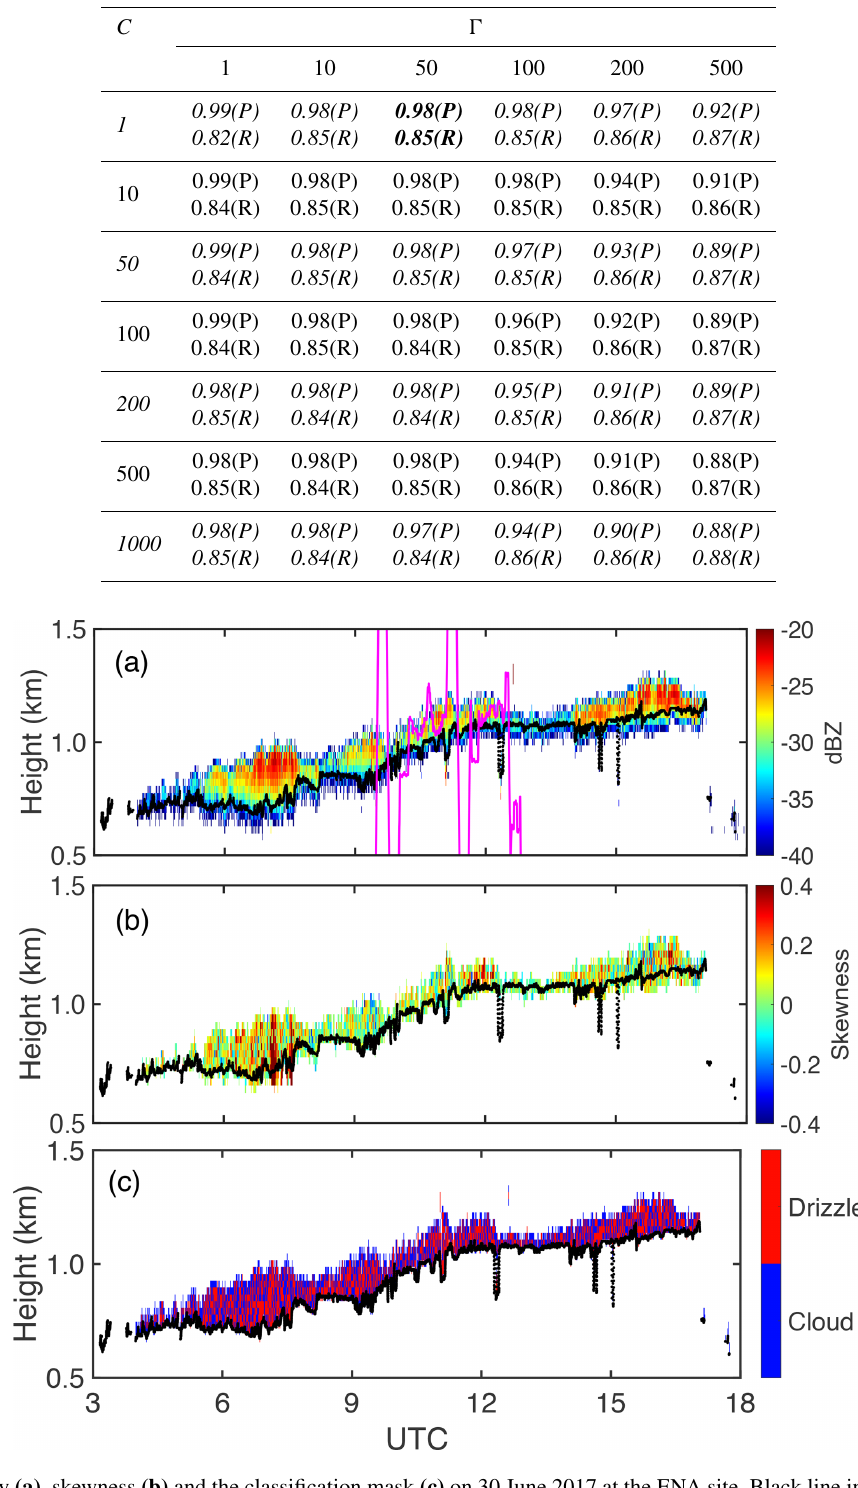
Figure 3. Reflectivity (a) , skewness (b) and the classification mask (c) on 30 June 2017 at the ENA site. Black line indicates the ceilometer- determined cloud base; magenta line in (a) indicates the altitude track of the aircraft during the observation